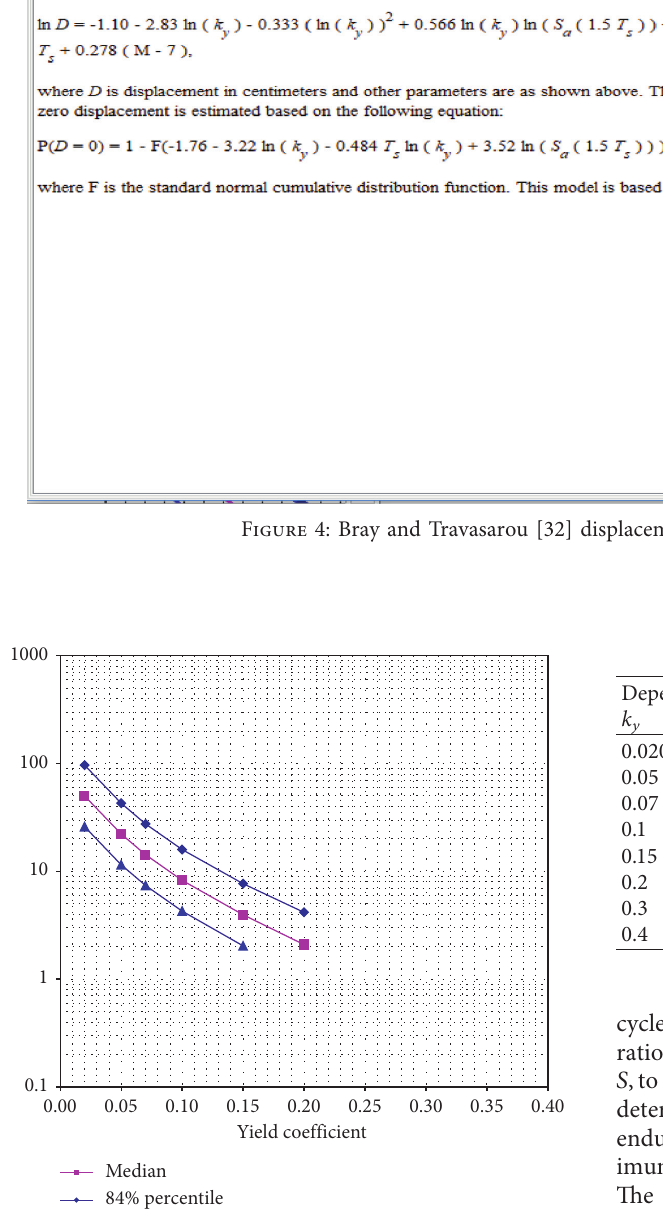
Figure 5: Bray and Travasarou [32] comparison of displacement to yield coefficient.